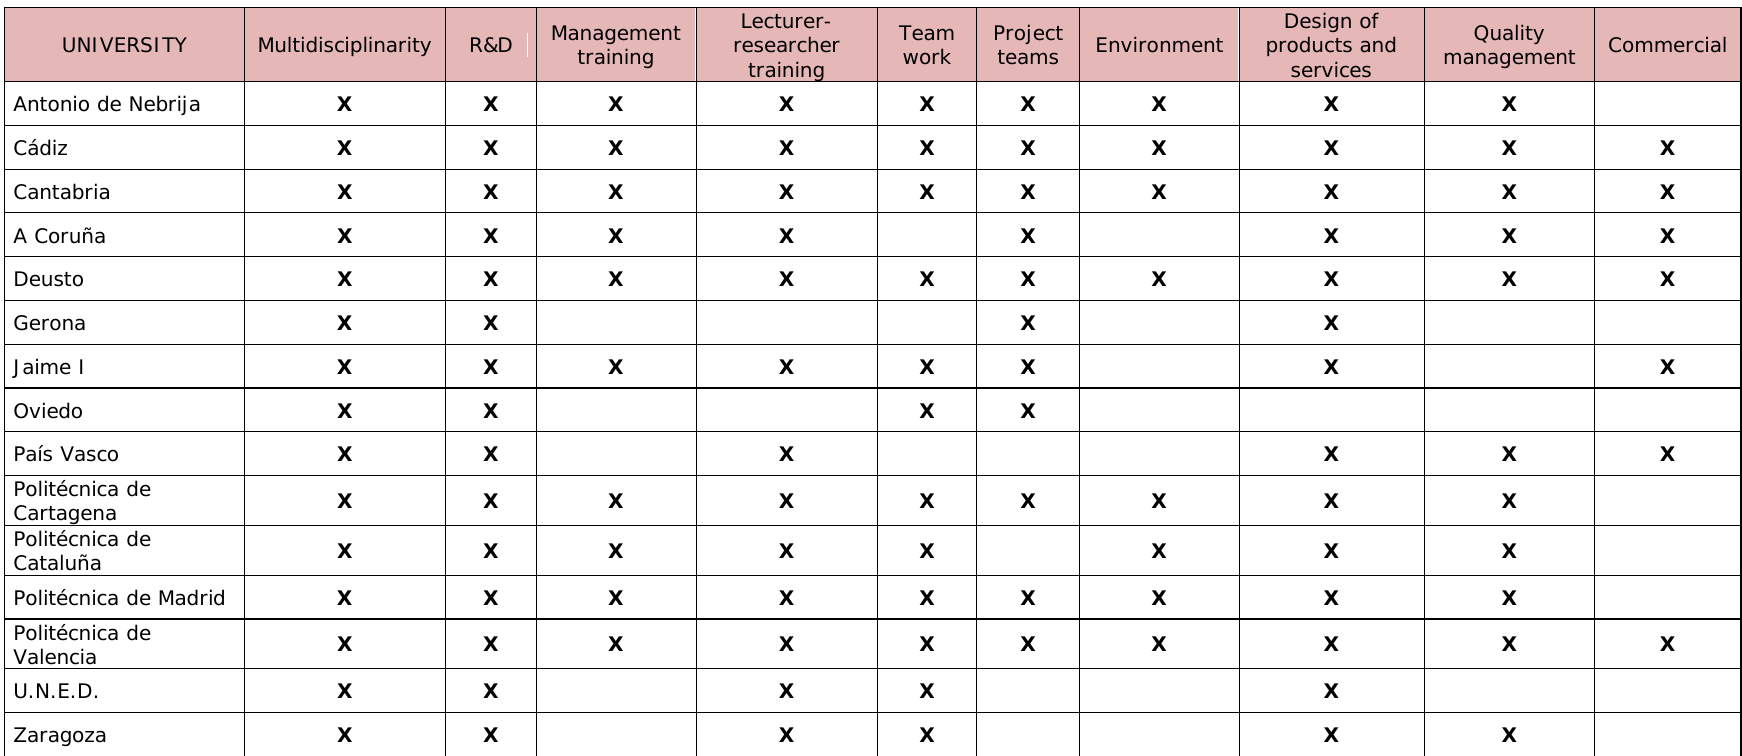
Table 1. “Competencies and skills in Spanish Industrial Engineering